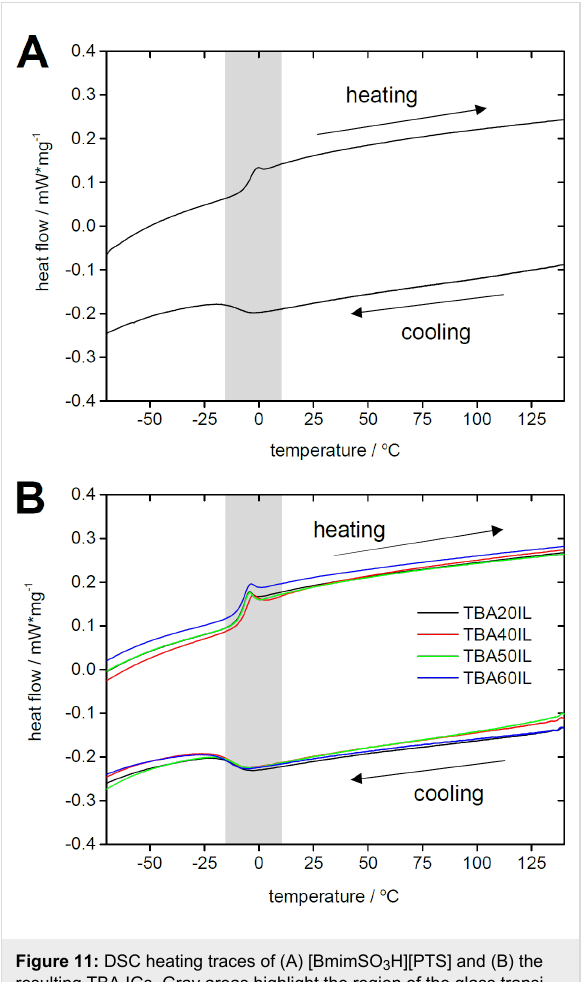
Figure 11: DSC heating traces of (A) [BmimSO 3 H][PTS] and (B) the resulting TBA IGs. Gray areas highlight the region of the glass transi- tion.